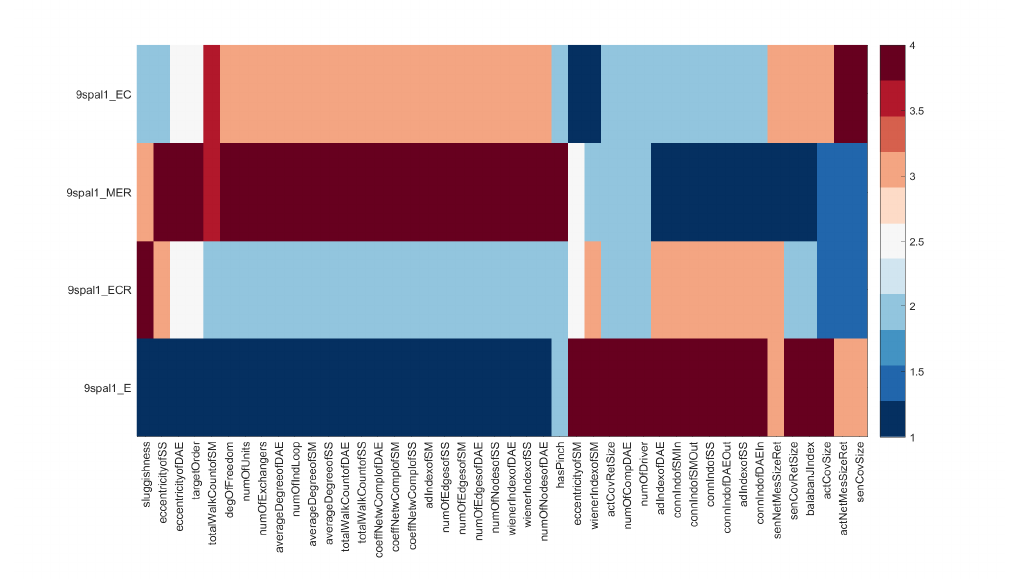
Figure 8. Correlations between the proposed network measures according to four HENs of the 9sp-al1 problem. The rows and columns were ordered based on similarities calculated based on the Spearman’s rank correlation. The colours of the map represent the rank